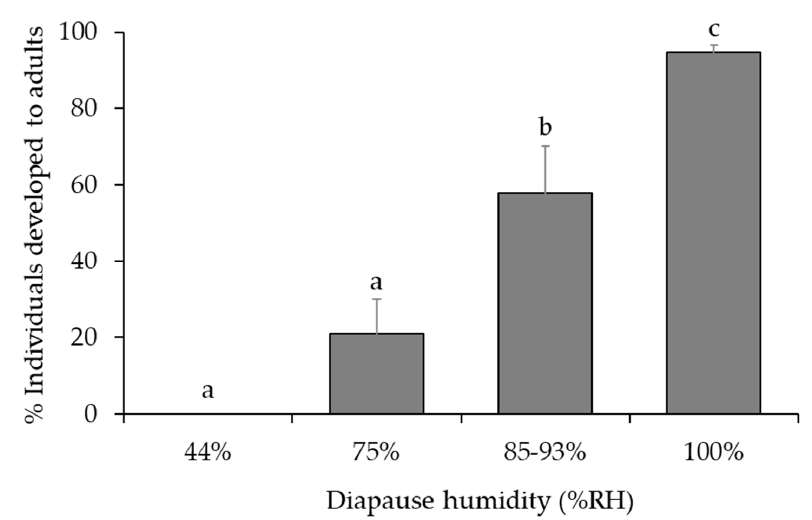
Figure 3. Effect of humidity conditions (see Table 1) on diapause survival of A. fukutai after being held at 15 °C and 12L:12D for one month and subsequently at 11 °C and 10L:14D for 6 months within parasitized A. chinensis eggs. Bars are mean + SE and different letters above the standard error bars indicate significant differences (Tukey’s HSD, p < 0.05).